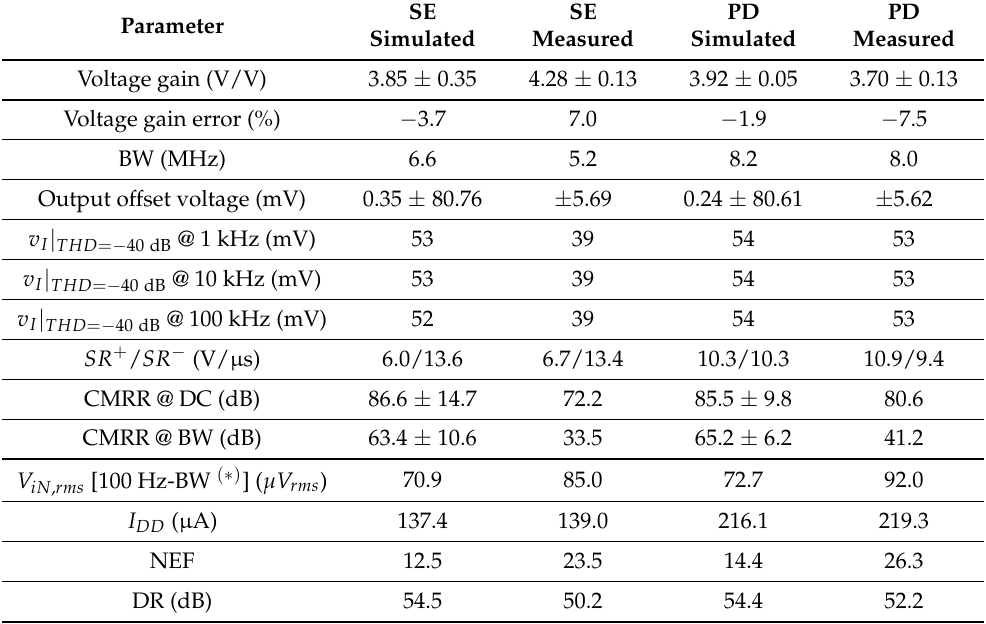
Table 3. Simulated vs. experimental performance of the designed ICF IAs (Technology: 180 nm